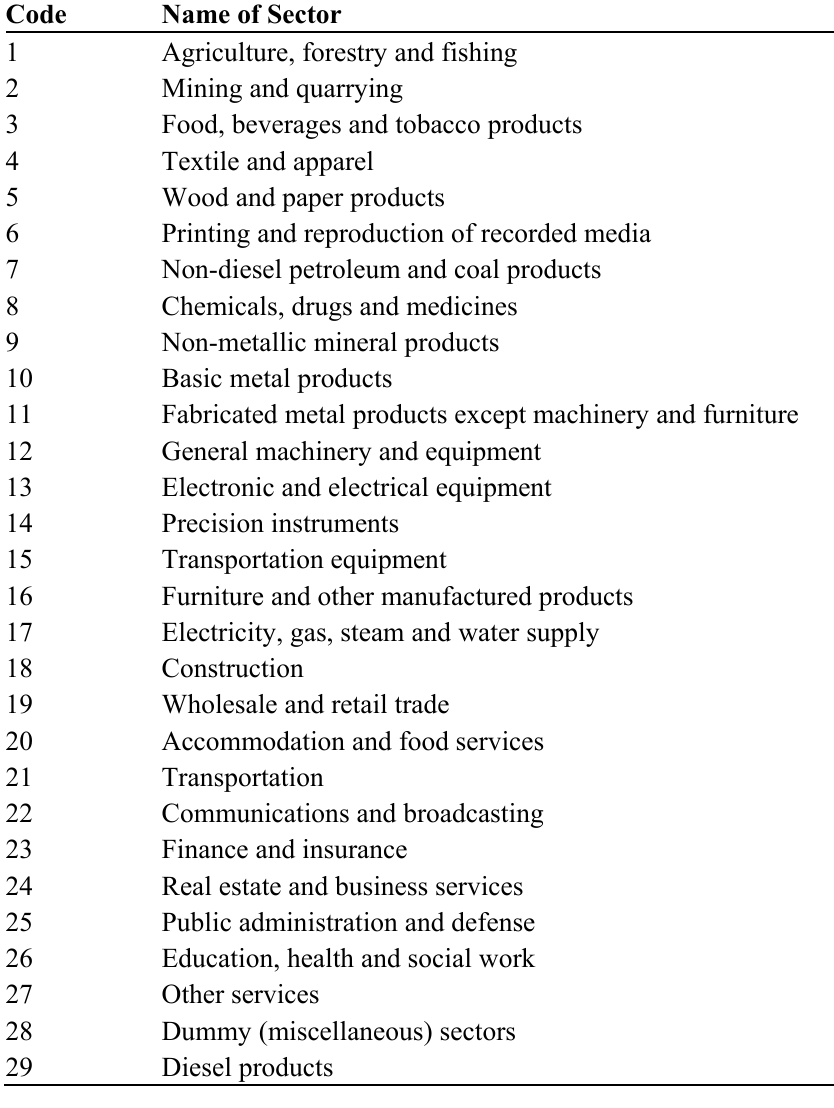
Table 1. Sector classification in this